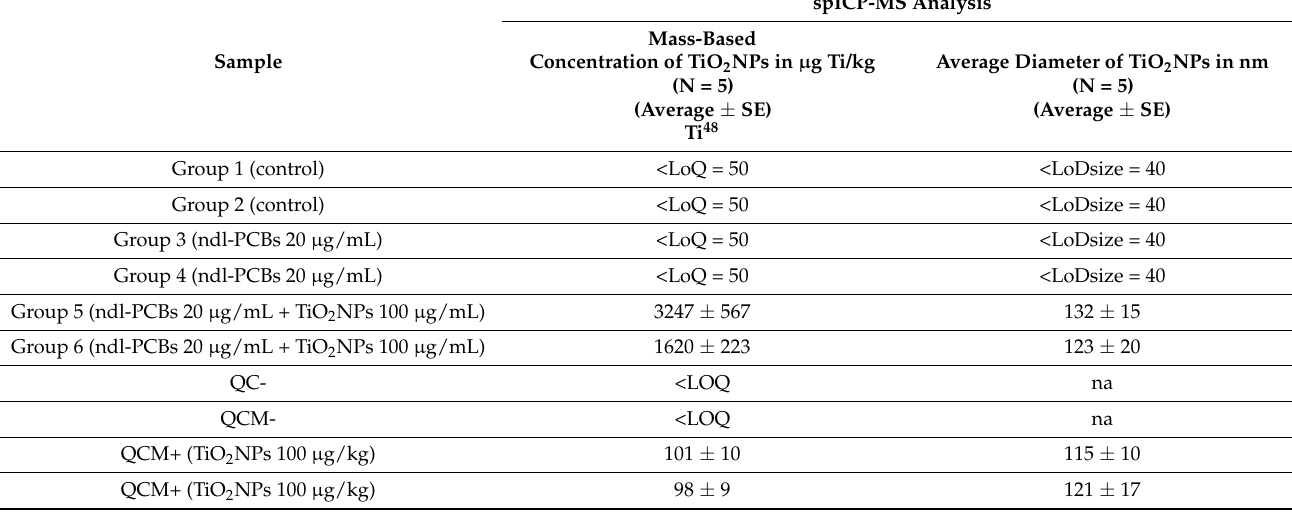
Table 1. Mass-based concentrations and particle sizes of TiO 2 NPs detected by spICP-MS in mussels after in vivo exposure to different treatments (with